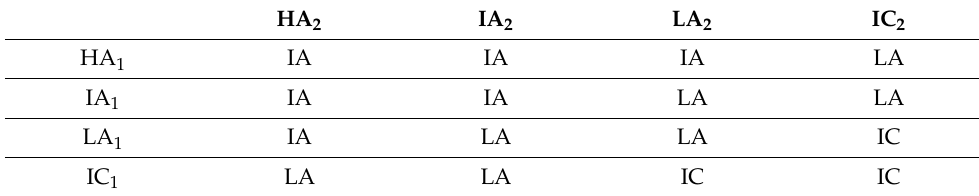
Table A3. The fuzzy rule table when u 3 is IA 3 .